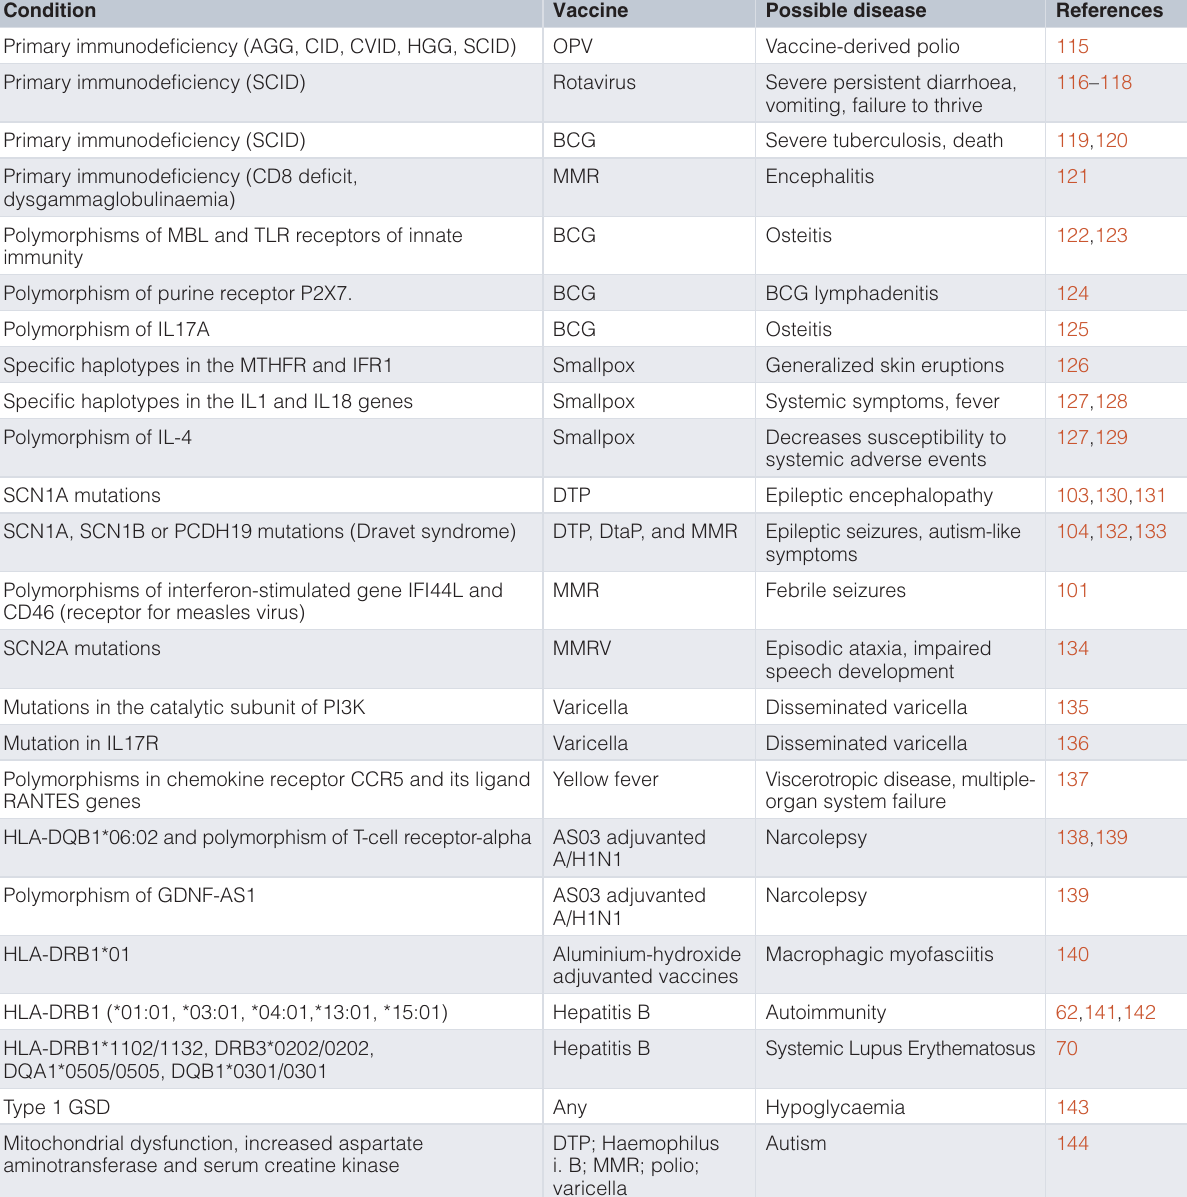
Table 1. Genetic disorders or variants that have been associated with adverse effects following